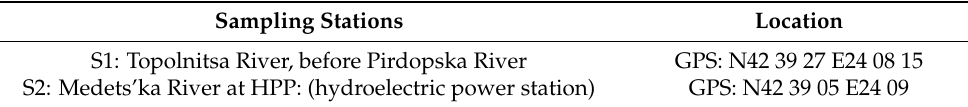
Table 4. The sampling